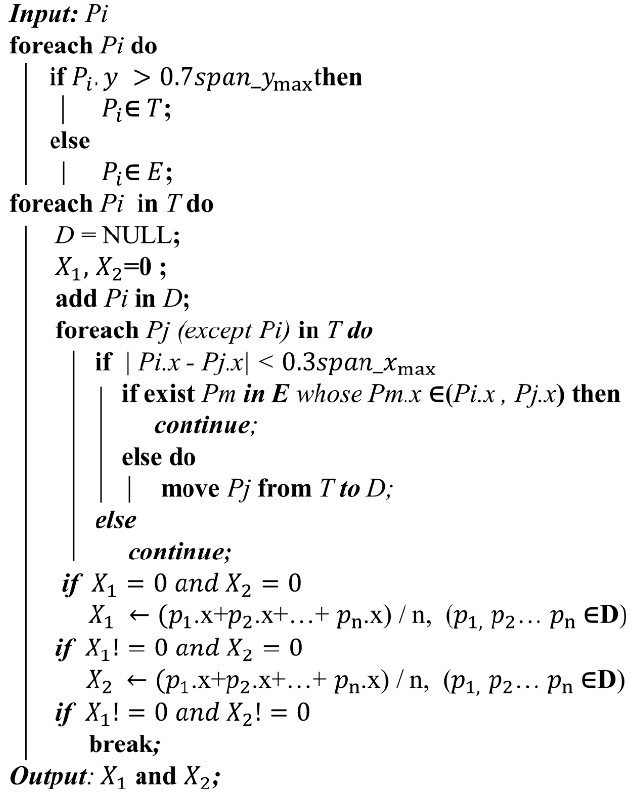
Figure 6. The algorithm for the center point extraction for leg region. After the approximate central point is determined, it is necessary to further identify the regional boundary, to accurately locate the coordinate area corresponding to the leg region along the direction of the body length (the y -axis direction of the three-dimensional point clouds). On the original distribution curve of span values for continuous slices, the span value at the boundary of the leg region shows attenuation. We proposed a “five-point gradient boundary recognition algorithm” to perform the boundary identification task. Assuming that the adjacent two “five-point clusters” on the span distribution curve are A1 (a1, a2, a3, a4, a5) and A2 (a6, a7, a8, a9, a10), respectively, the average gradient P of these five consecutive points can be calculated from Equation (1):